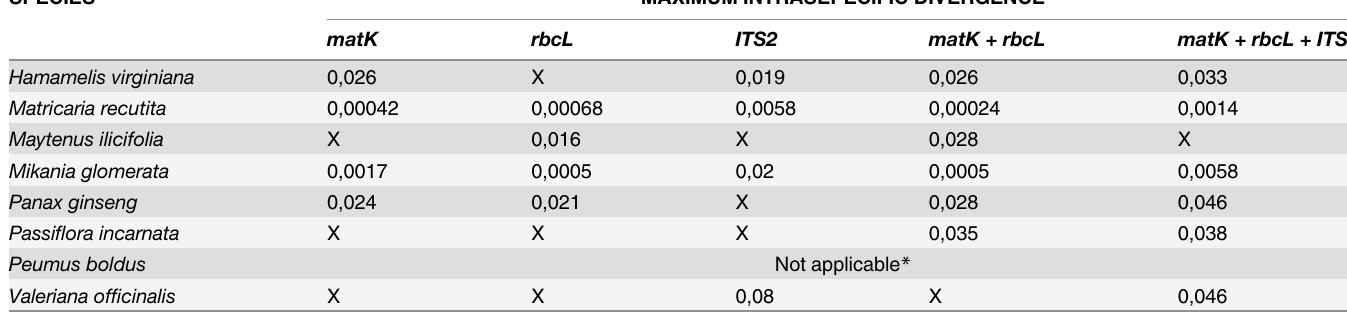
Table 3. Barcode gap analyses.